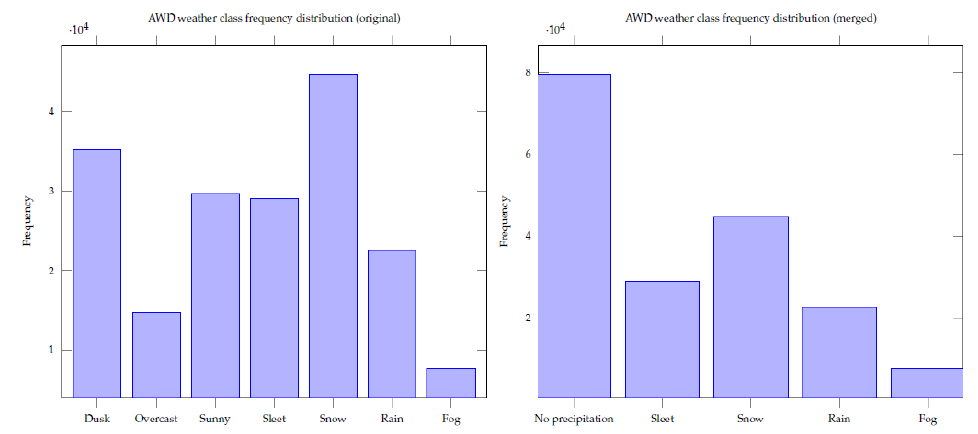
Figure 1. AWD weather class frequency